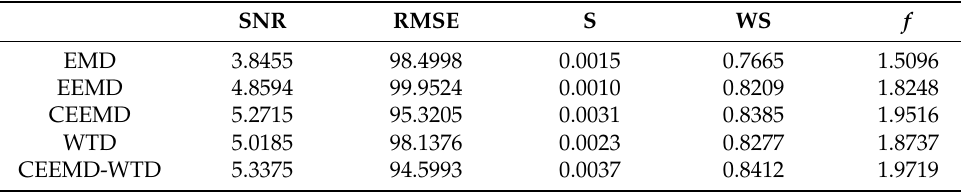
Table 1. Simulated signal denoising evaluation.